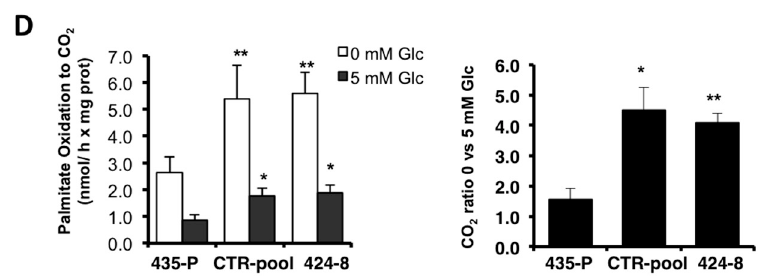
Figure 6. GRP94 ablation impairs survival in glucose restriction conditions and increases lipid content. ( A ) Lipid content was analyzed by fluorescent staining with Nile red (TFA) and filipin (cholesterol) for V5CA1-CTR, 424-2 and 424-8 cells (40x, one representative experiment of three, error bars represent SD of > 180 cells analyzed). ( B ) SREBP-1 and LXR α expression was quantified vs. tubulin. ( C ) Survival of BrM metastatic cells after GRP94 ablation cultured without glucose ± etomoxir (200 µ M). Bars represent relative survival of each cell line vs. its control (non-treated) with glucose, error bars represent SD of three independent experiments. ( D ) Palmitate oxidation was calculated after adding 14 C-palmitate and measuring released 14 CO 2 production at 5 or 0 mM glucose (error bars represent SEM of three independent experiments). (right) Palmitate oxidation ratio at 0 mM glucose vs. 5 mM glucose. For all panels, significance determined with t -test. * p < 0.05, ** p < 0.01, *** p < 0.001.